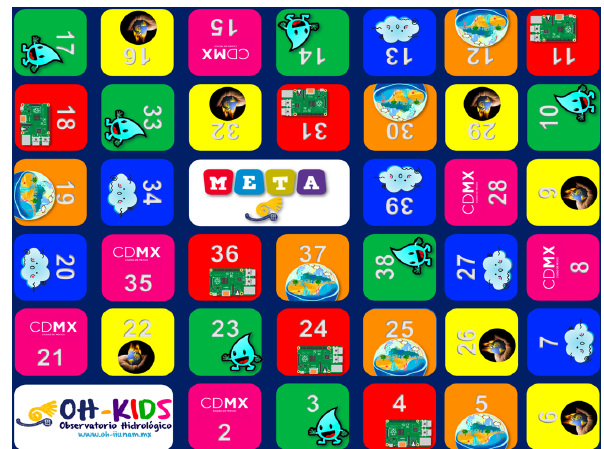
Figure 6. The Hydro-thon game mat.